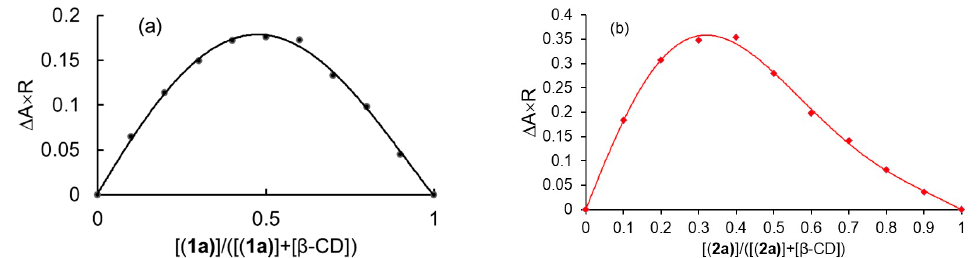
Figure 2. Job’s plots for inclusion complexes ( 1a ) (0.1 mM) and β -CD (0.1 mM) ( a ) at 312 nm and ( 2a ) (0.1 mM) and β -CD (0.1 mM) ( b ) at 272 nm.